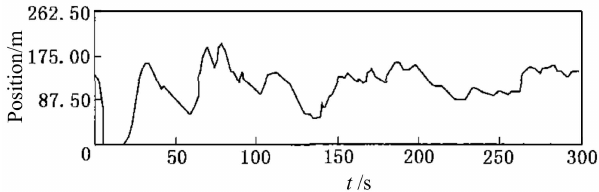
Figure 20. Change process of the interface in the FSPF in the SCTT [38].